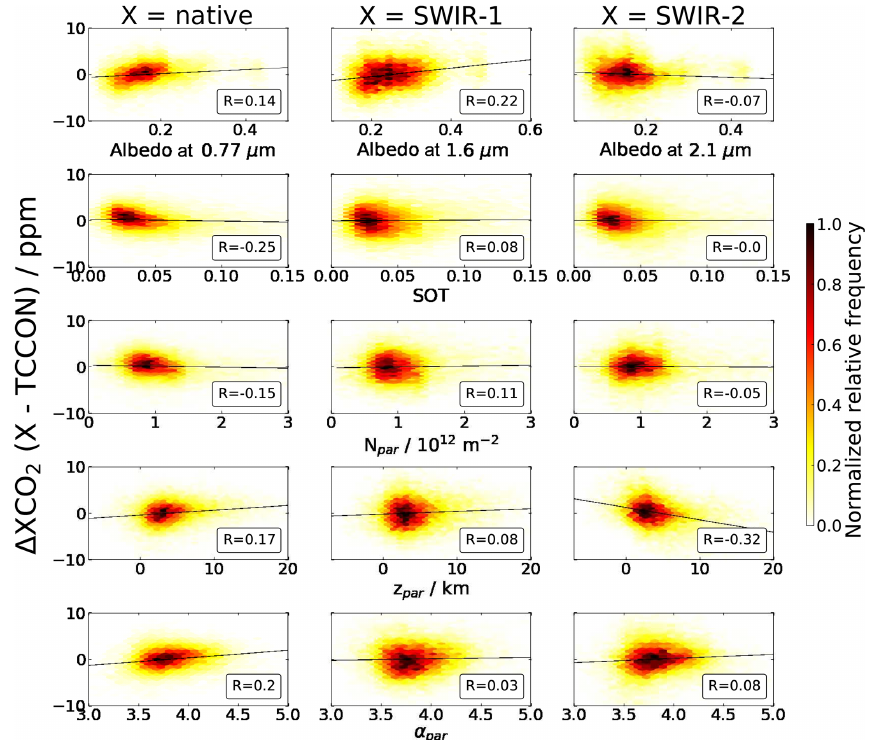
Figure 6. Differences between TCCON and native GOSAT (left), SWIR-1 (middle) and SWIR-2 (right) for selected geophysical parameters. Pearson’s correlation coefficient R is shown in the corner of each subplot. The solid line is a linear fit to the data. Color encodes relative occurrence of data points.